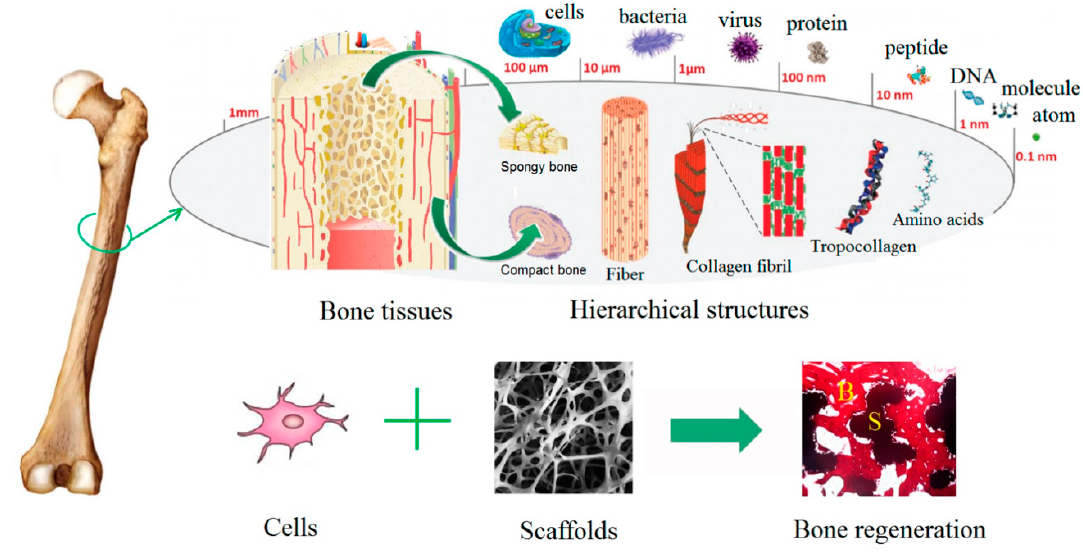
Figure 4. Schematic representation of bone structure hierarchy and anatomy and the synergistic effects of cells and scaffolds involved in bone regeneration. Reprinted from an open-access source [114].